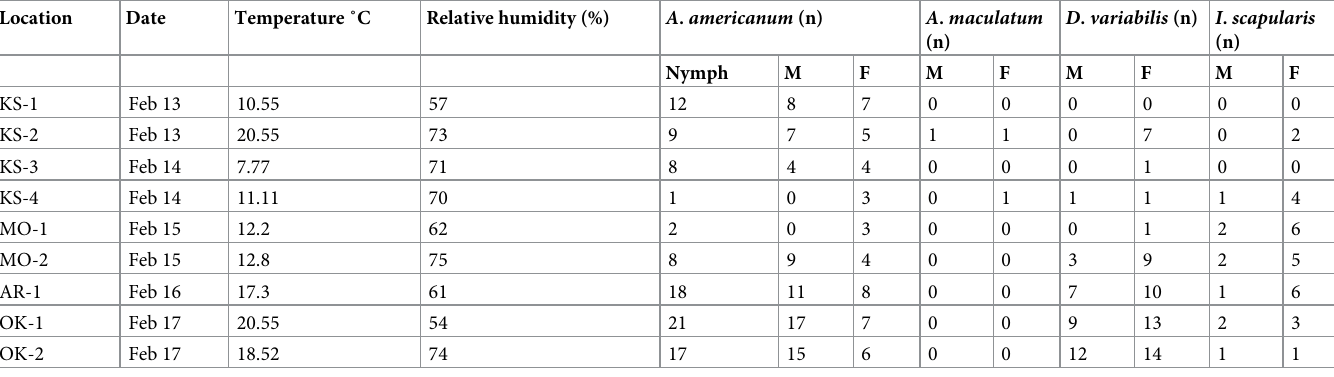
(n) = number of live ticks collected.